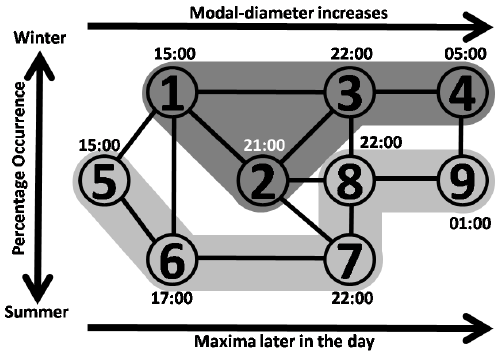
Fig. 5. Cluster proximity diagram. Each node in the diagram rep- Figure 5. Cluster Proximity Diagram. Each node in the diagram represents a cluster resents a cluster and each cluster is arranged according to its sim- ilarity to its neighbour. The modal diameter increases from left to and each cluster is arranged according to its similarity to its neighbour. The modal right across the diagram and the two shaded regions indicate those diameter increases from left to right across the diagram and the two shaded regions clusters which are most frequently detected in central Europe (dark 3 Fig. 6. Plot showing how the modal diameters MD of the average indicate those clusters which are most frequently detected in central Europe (dark grey) and those which are not (lighter shades of grey). The times cluster spectra vary with the hour HR of their maximum particle grey) and those which are not (lighter shades of grey). The times positioned next to positioned next to each node indicate when the maximum particle number concentration [PN]. The purple (1, 2, 3 and 4) and blue (5, each node indicate when the maximum particle number concentration of each cluster number concentration of each cluster occurred. 6, 7, 8 and 9) colours depict two aggregated trends observed in the occurred. data based on a south-to-north and west-to-east air mass movement. The rates of growth from cluster to cluster are: for the purple (1, 2, 3 and 4) 0.9, 0.9 and 1.0nmh − 1 ; and for the blue (5, 6, 7, 8 and 9) equal 0.59, 0.55, 0.82 and 0.67nmh − 1 (fitted lines: y = 0 . 96 x + 12 . 8 and y = 0 . 67 x + 8 .